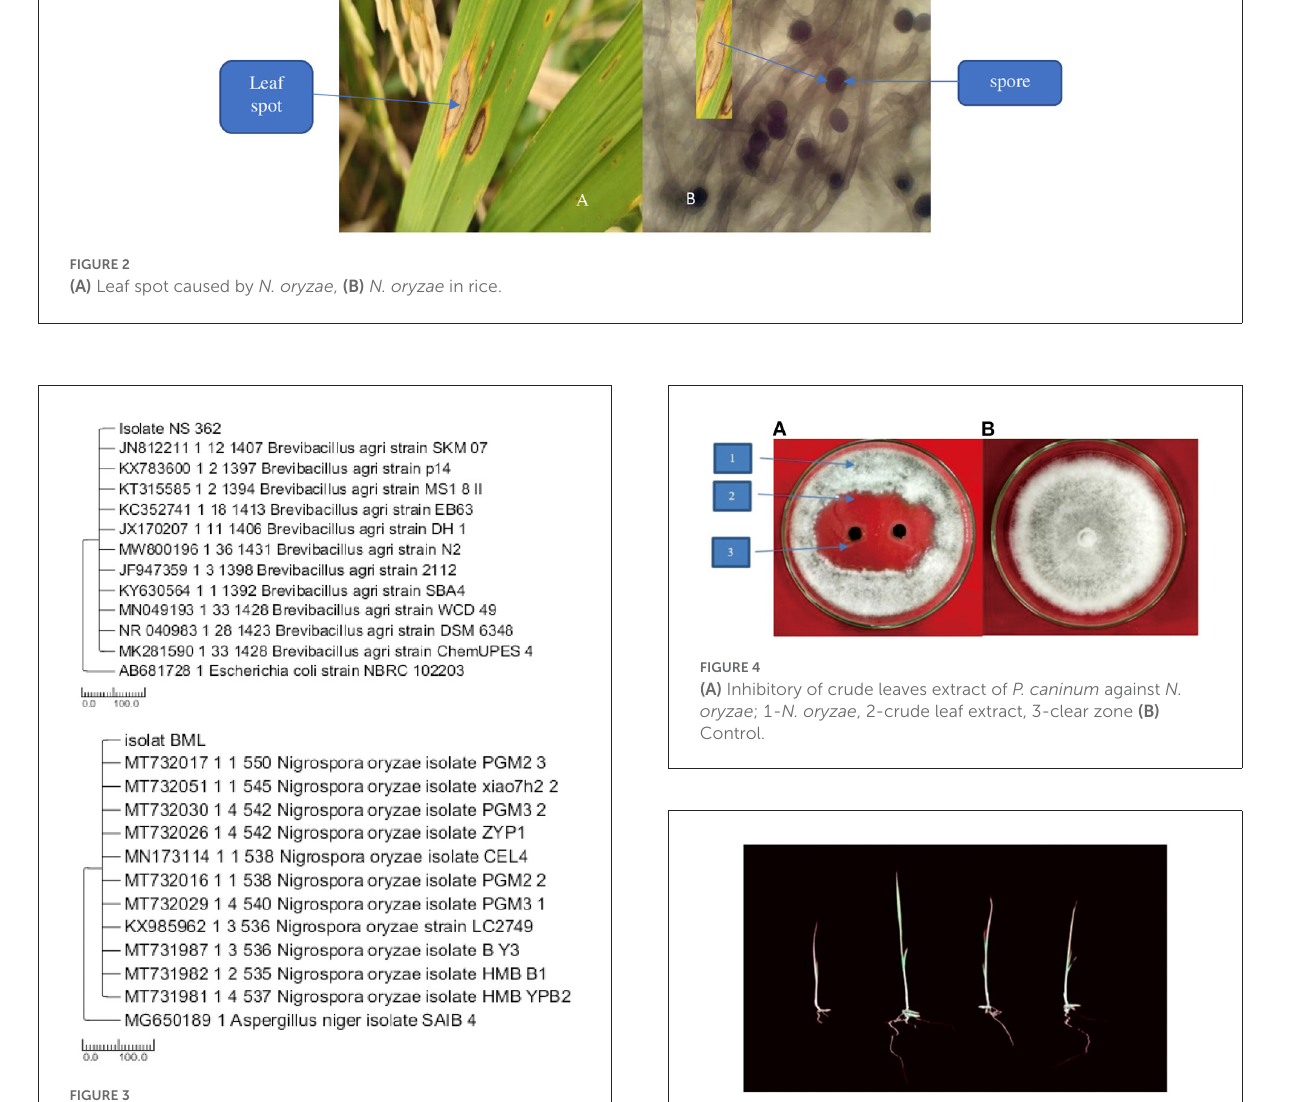
FIGURE5 Root length from left to right F0, F3, F1,